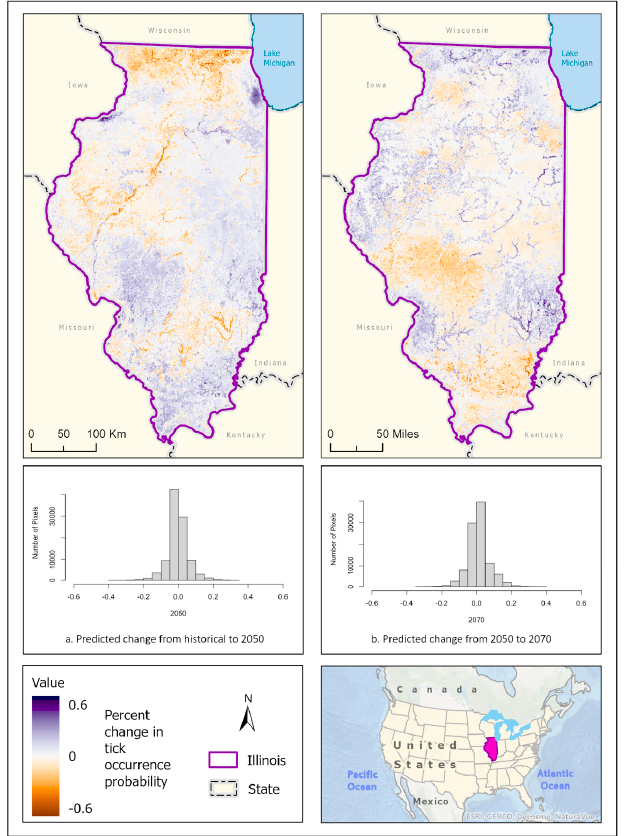
Figure 7. Percent change in the likelihood of D. variabilis occurrence between the historical climate and 2050 ( left ) and from 2050 to 2070 ( right ). Red shades indicate a reduced likelihood of occurrence (negative change), and blue shades indicate an increased likelihood of occurrence (positive change). The histograms represent the number of pixels (y − axis) containing the binned percentage likelihood (x − axis) of D. variabilis suitable habitat across the map. Inset map indicates the location of Illinois within the United States/North America.